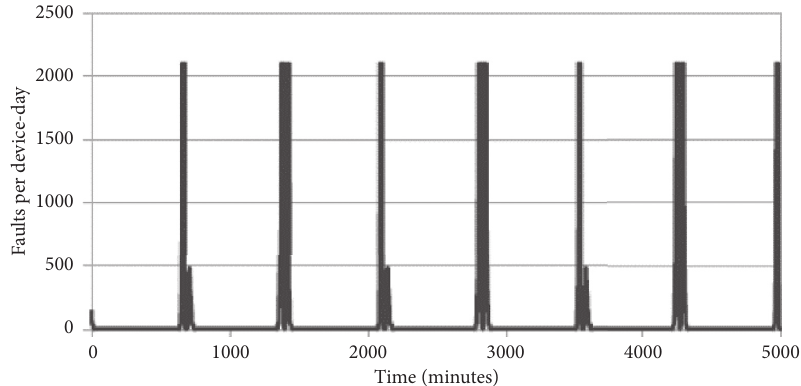
Figure 6: Expected fault rate of HEO (taken from [6]).